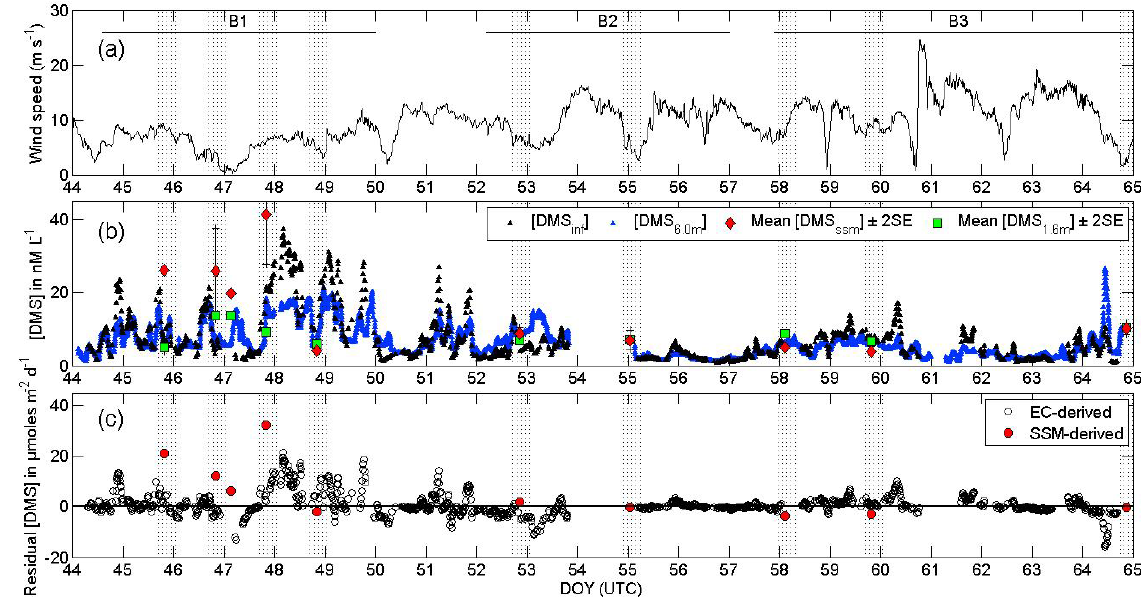
Figure 5. (a) Wind speed normalized to 10m. (b) Flux-inferred concentrations of seawater DMS, [DMS inf ] (black triangles), overlain with the mean for [DMS SSM ] (red diamonds), [DMS 1 . 6m ] (green squares), and [DMS 6 . 0m ] (blue triangles). [DMS inf ] was calculated from continuous EC flux measurements and COARE k values based on local conditions. [DMS inf ] and [DMS 6 . 0m ] data sets were smoothed using a moving average algorithm with a span of 1h. Error bars indicate 2 × standard error of the mean of replicate samples. Shaded areas indicate the period from 3h prior to and 5h after SSM sampling. Periods encompassing intense sampling within algal blooms (B1, B2, and B3) are indicated by the horizontal lines at the top of the graph. Sea-surface microlayer measurements for DOY 47.1 and 64.8 coincide with a gap in EC air–sea flux data. On DOY 48.8, changes in [DMS 6 . 0m ] during station occupation indicate the SSM sample is unlikely to be representative of the SSM for the entire station. (c) SSM-derived residual [DMS] (solid red circles) compared with EC-derived residual [DMS] (solid black